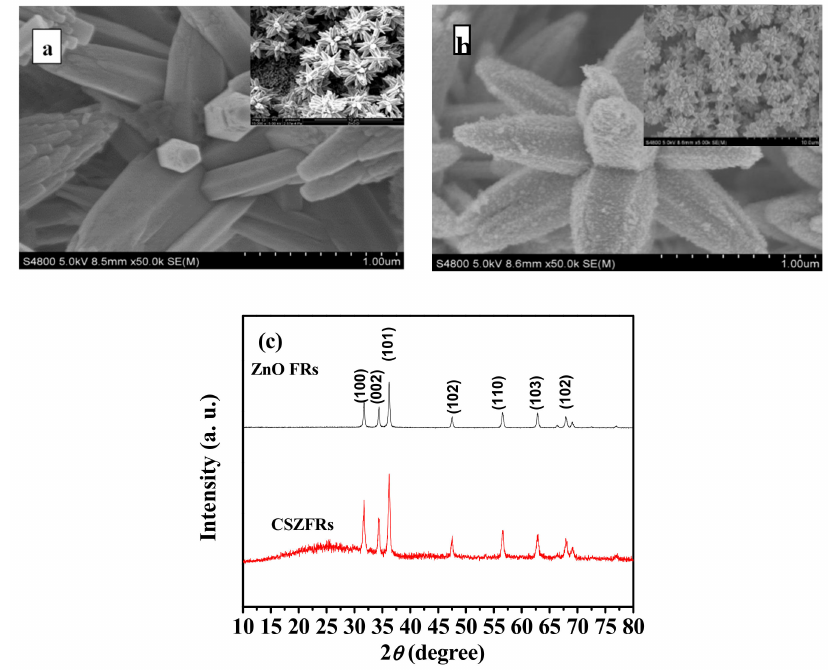
Figure 2. FESEM images of ( a ) ZnO FRs and ( b ) CSZFRs. The insets of ( a ) and ( b ) are images with lower magnification; ( c ) XRD patterns of CSZFRs and ZnO